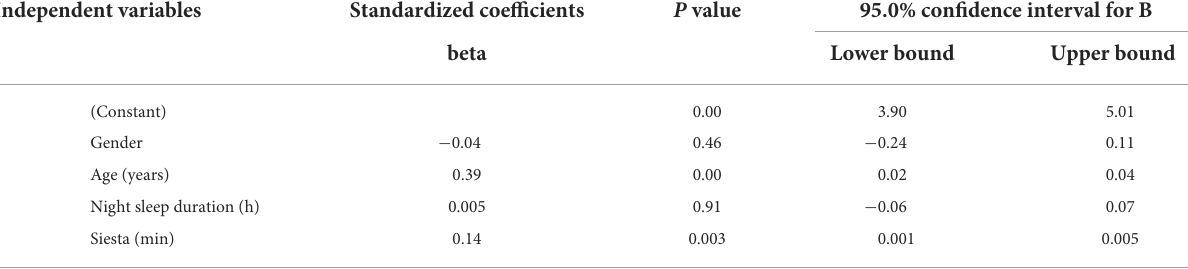
TABLE 3 Linear regression analysis of HbA1C (%) with different confounding variables.